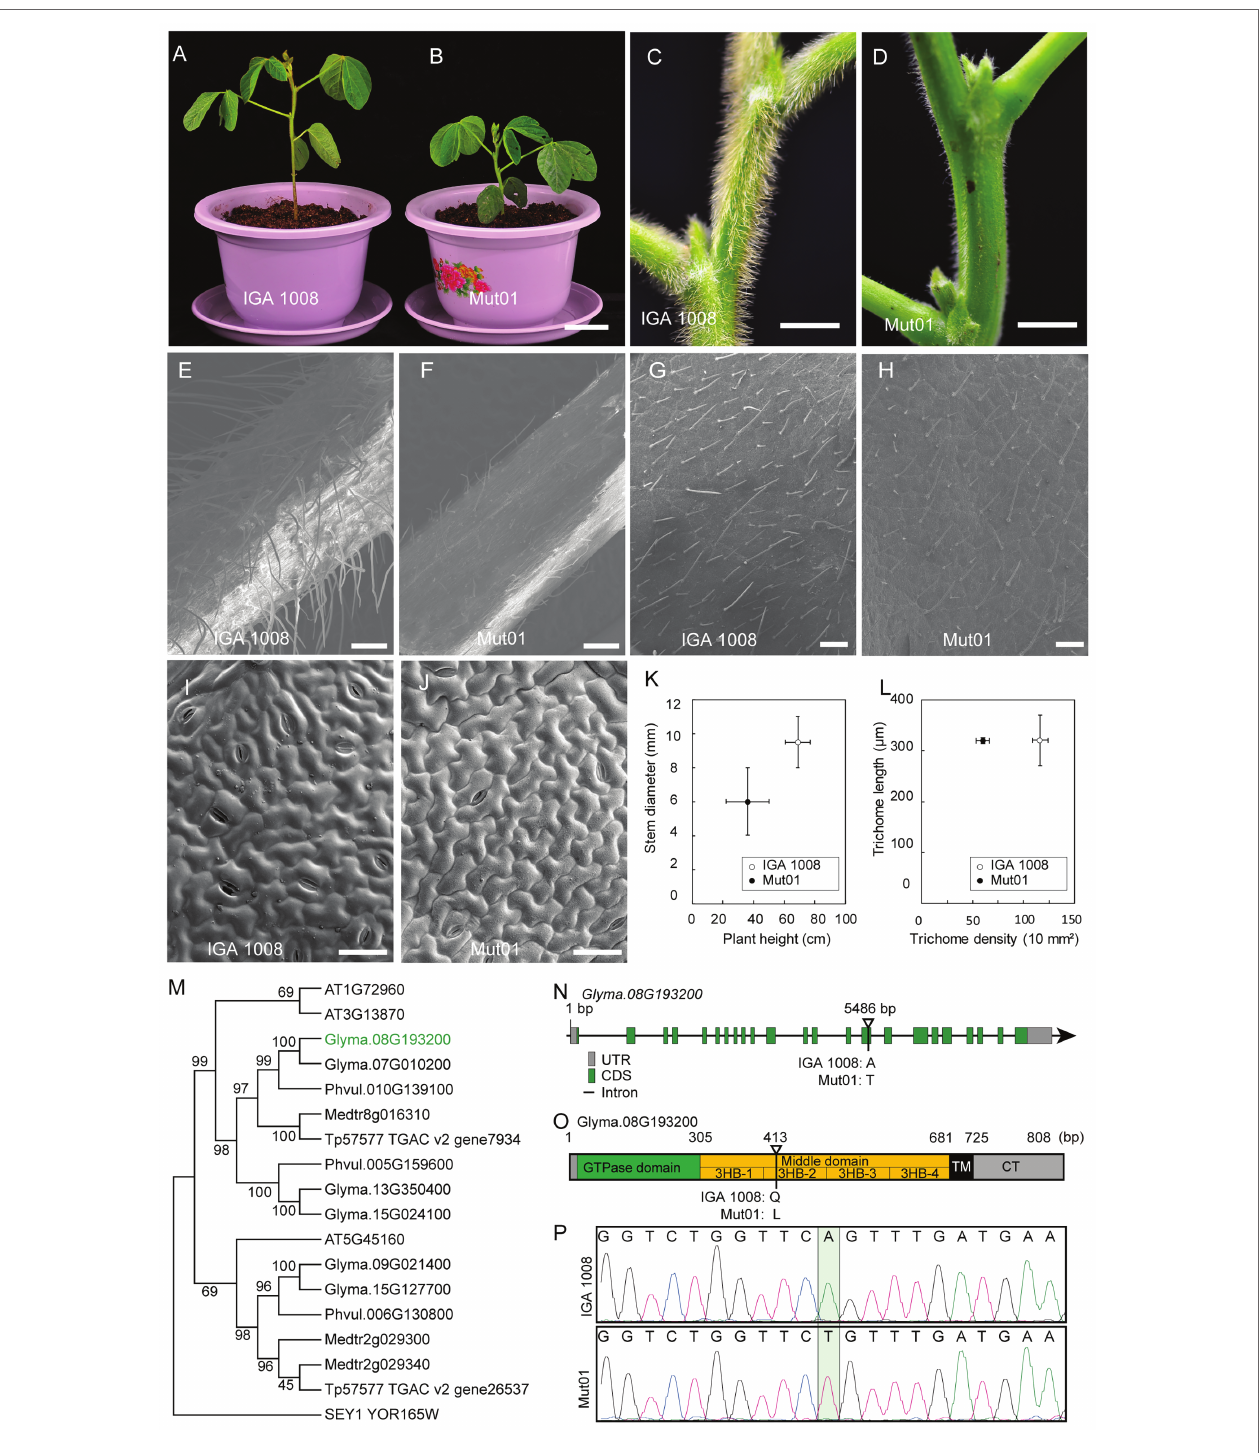
FIGURE 5 | Characterization of phenotype of mutant from Mut01 and causal mutation in gene Glyma.08G193200 . (A,B) Mutant and wild-type IGA 1008 phenotype of whole plants at V4 stage. Scale bar, 5 cm. (C,D) Mutant and wild-type phenotype of stem. Scale bar, 5 mm. (E,F) Mutant and wild-type phenotype of petiole. Scale bar, 500 μ m. (G,H) Mutant and wild-type phenotype of leaf trichome. Scale bar, 500 μ m. (I,J) Mutant and wild-type phenotype of the leaf pavement cell. Scale bar, 50 μ m. (K) Plant height and stem diameter of mutant and wild type. Values are mean ± SD ( n = 6 plants). (L) The trichome length and density of the mutant and wild-type leaf. Values are mean ± SD; 150 trichomes were used to calculate the mean values of trichome length of mutant and wild type. (M) The phylogenetic tree of RHD3 was obtained from Arabidopsis , Glycine max , Medicago truncatula , Phaseolus vulgaris , Trifolium pretense , and Saccharomyces cerevisiae